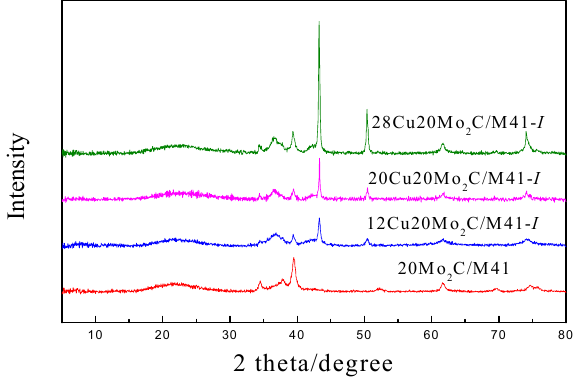
Figure 2. XRD patterns of the x Cu20Mo 2 C/M41- I samples. Table 1. The average Cu crystallite size of the x Cu20Mo 2 C/M41- I samples. Samples